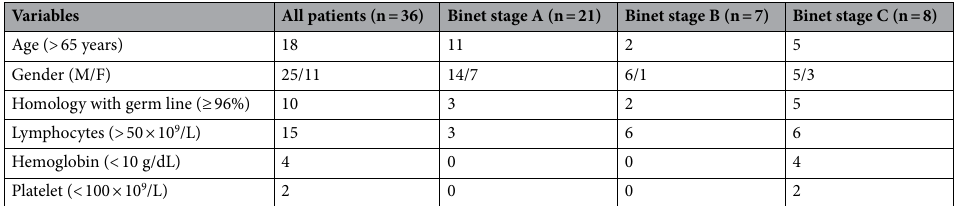
Table 1. Characteristics of all the untreated CLL patients stratified according to Binet stages.